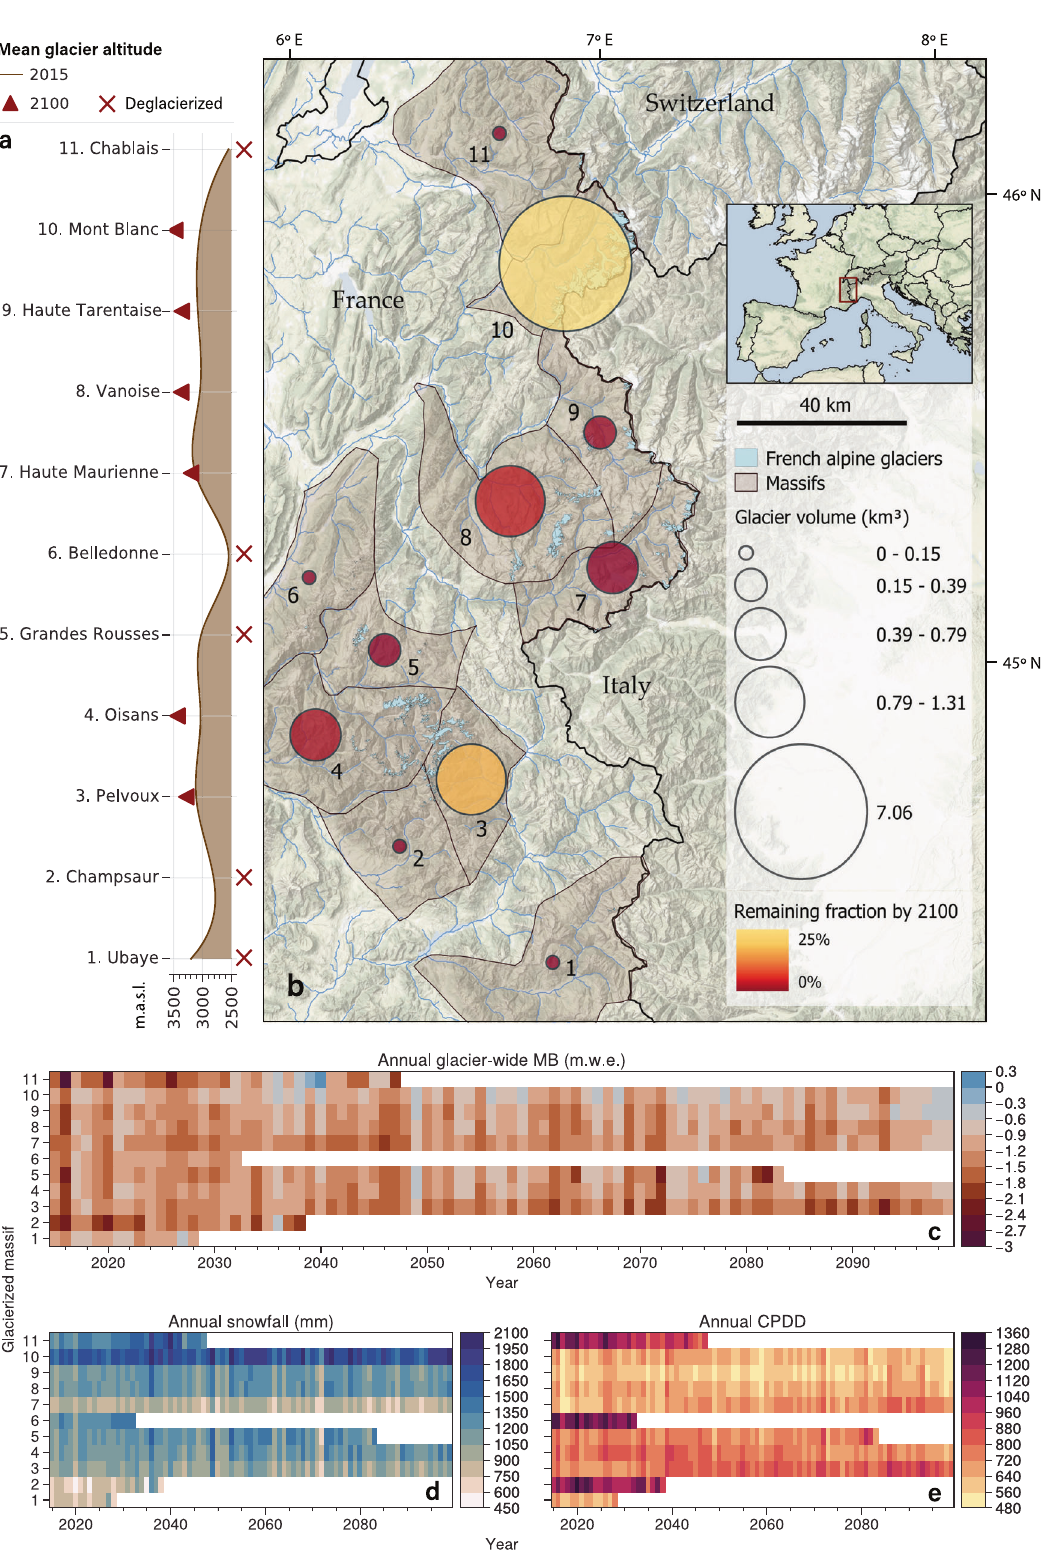
Fig. 2 Projected glacier and climate evolution per glacierized massif between 2015 and 2100 under RCP 4.5. a Projected mean glacier altitude evolution between 2015 and 2100. Massifs without glaciers by 2100 are marked with a cross, b Glacier ice volume distribution per massif, with its remaining fraction by 2100 (with respect to 2015), c Annual glacier-wide MB per massif, d Annual snowfall per massif, e Annual cumulative positive degree-days (CPDD) per massif. All values correspond to ensemble means under RCP 4.5. Years in white in c-e indicate the disappearance of all glaciers in a given